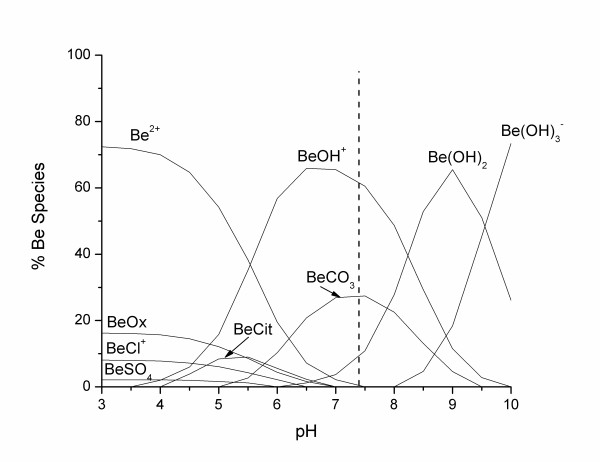
Speciation of Be in the LMW of serum fluid ([Be] 5.8*10-5 mM; [Ca] 1.3 mM; [Cl] 108 mM; [CO3] 24 mM; [K] 4.2 mM; [Mg] 0.8 mM; [Na] 142 mM; [PO4] 2 mM; [SO4] 0.5 mM; [Cit] 0.1 mM; [Ox] 0.01 mM).